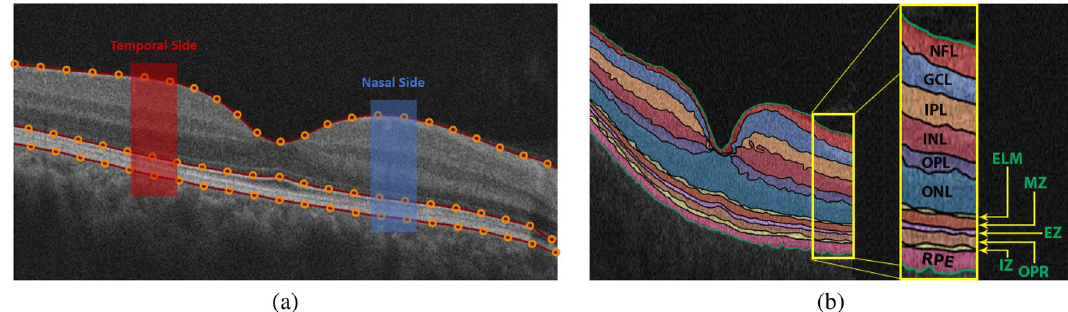
Figure 2. Illustrative example of the proposed segmentation approach: ( a ) detection of vitreous and choroid, and ( b ) the final twelve segmented layers.